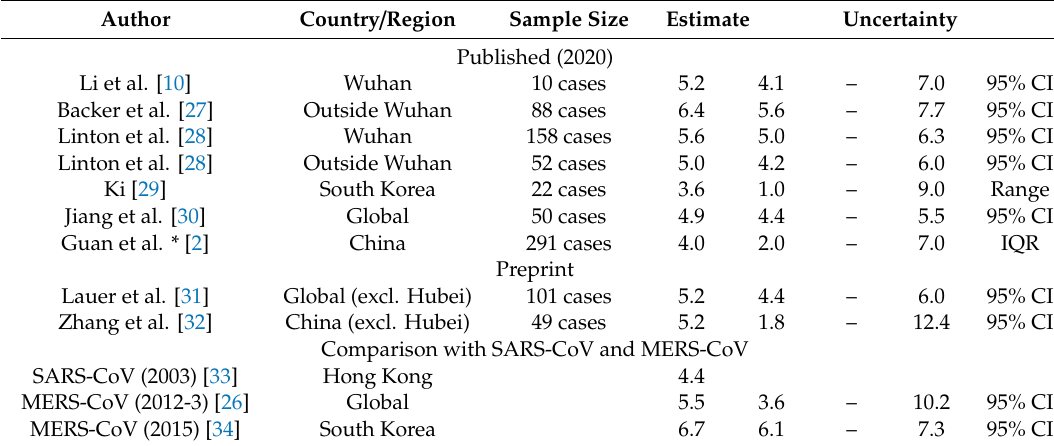
Table 3. Estimated incubation period from selected studies.